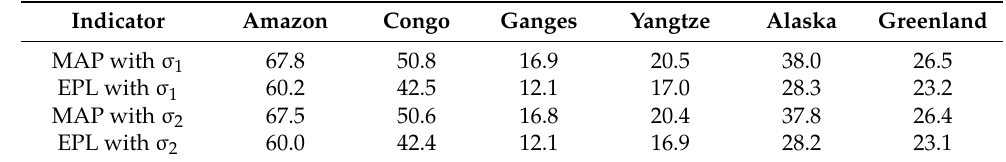
Table 3. The mean formal error StD of regional mass anomalies calculated from the left panel of Figure